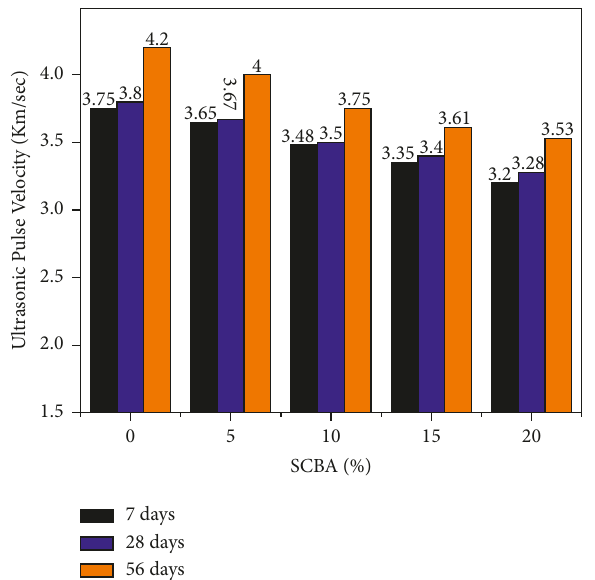
Figure 30: Ultrasonic pulse velocity of OPC-SCBA concrete [66]. Table 13: The energy necessary to produce the cement (En) and the energy performance (Ep) of mortars at 28 days.